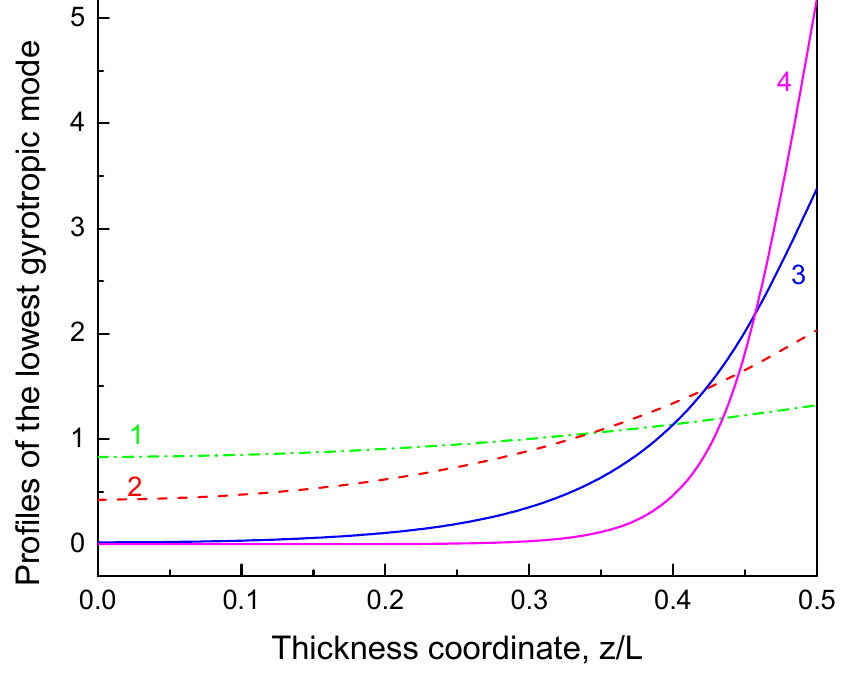
Figure 2. The normalized profiles of the lowest vortex gyrotropic mode calculated using the Mathieu function approximation, Equation (12b). The values of the dot aspect ratio β : 0.3 (1), 0.5 (2), 1.0 (3), and 2.0 (4). The reduced dot radius r = R / L e = 10 .